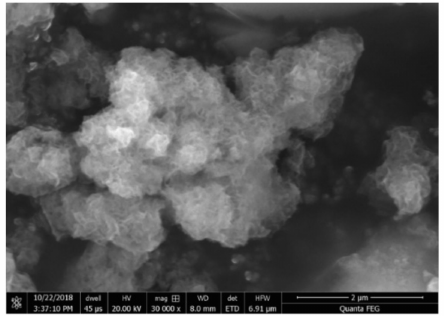
Figure 2. SEM image of